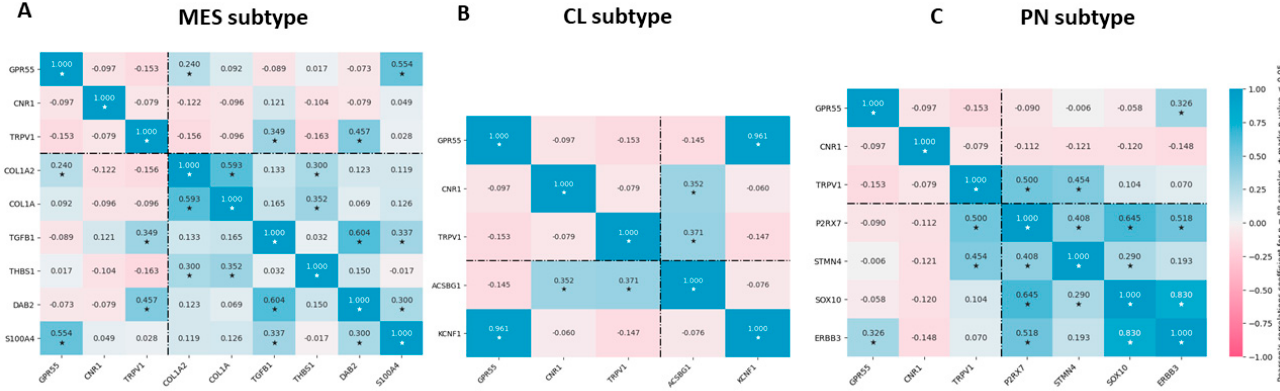
Figure 5. Correlation matrix of GPR55, CNR1 , and TRPV1 with MES, CL, and PN markers. Behnan et al. [38] suggested the following markers: ( A ) MES ( COL1A2, COL1A, TGFBI, THBS1, DAB2 , and S100A4), ( B ) CL ( ACSBG1 and KCNF ), and ( C ) PN ( P2RX7, STMN4, SOX10 , and ERBB3 ). GPR55 correlated with MES markers COL1A2 (r = 0.24) and S100A4 (r = 0.55), very strongly with CL marker KCNF1 (r = 0.96), and poorly with PN marker ERBB3 (r = 0.33). CNR1 did not markedly correlate with any of these markers. TRPV1 correlated with MES markers DAB2 (r = 0.46) and TGBF1 (r = 0.35), CL marker ASCBG1 (r = 0.37), and most highly with PN markers P2RX7 (r = 050) and STMN4 (r = 045). The star under the correlation number (r) between the two genes in the boxes, means that the correlation was significant ( p < =0.05) n ® (* p < 0.05).